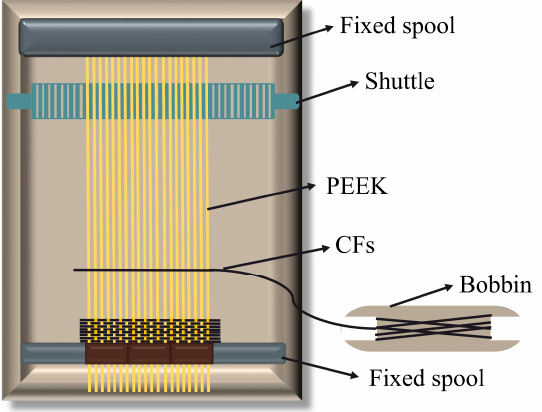
Figure 1. The schematic diagram for the fabrication of CF/PEEK plain weave fabric.